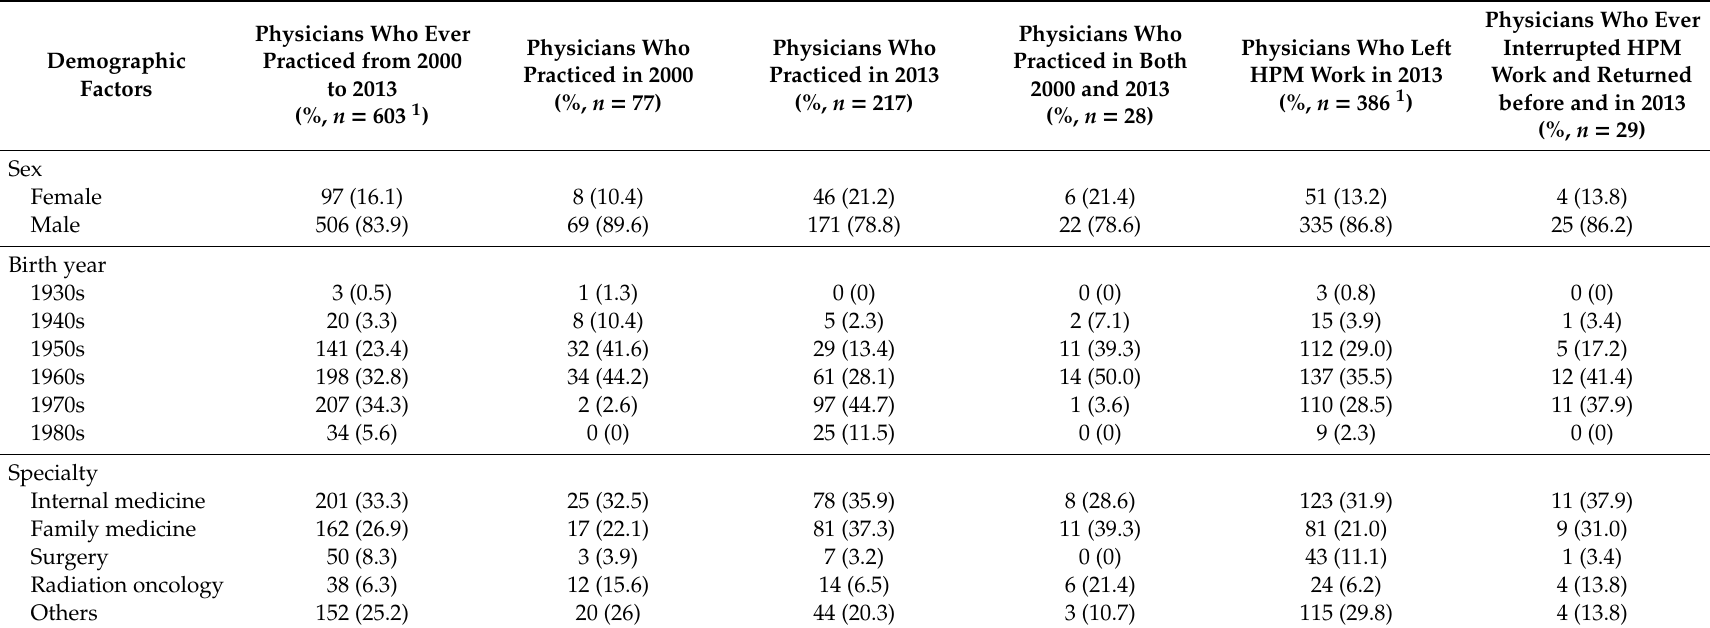
Table 2. Characteristics of physicians engaged in inpatient hospice and palliative care in